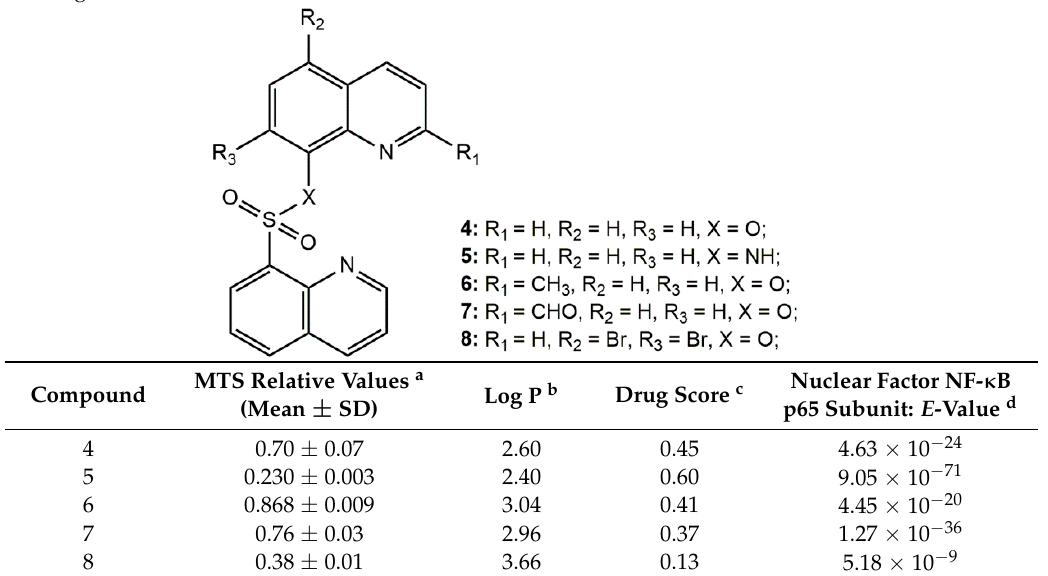
Table 2. Bioactivity of the tested compounds ( 4 – 8 ) against Hep3B cell lines and the related docking results.